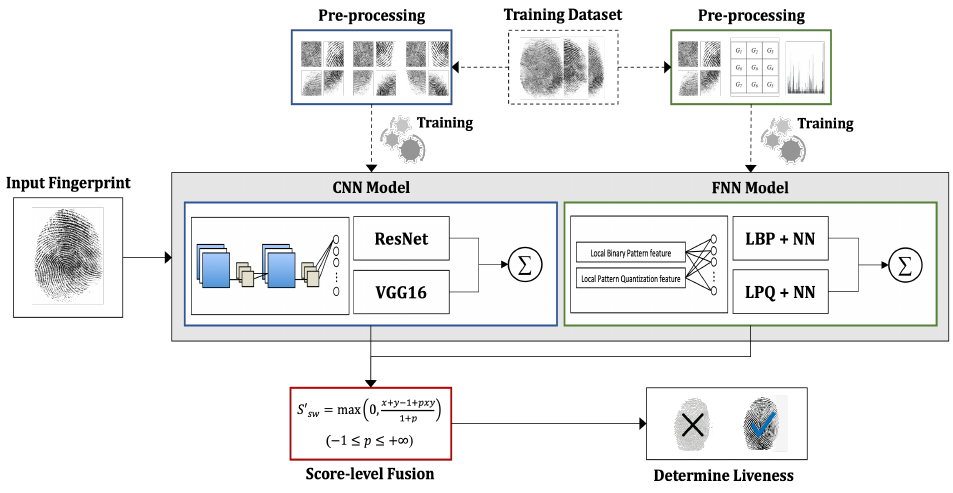
Figure 1. An overview of proposed